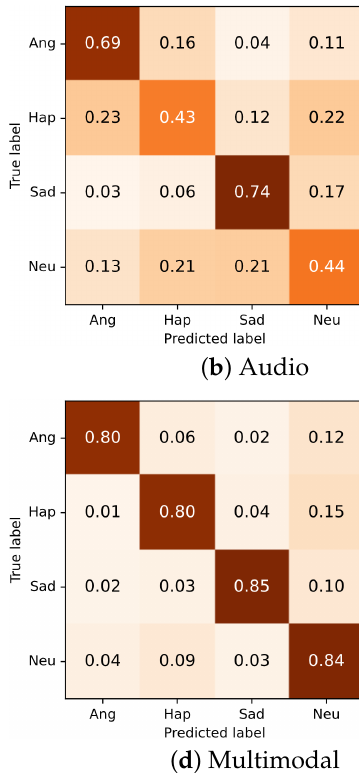
Figure 10. Confusion matrix for each modality. For skeleton modality, the two-stream self-attention enhanced spatial temporal graph convolutional network is